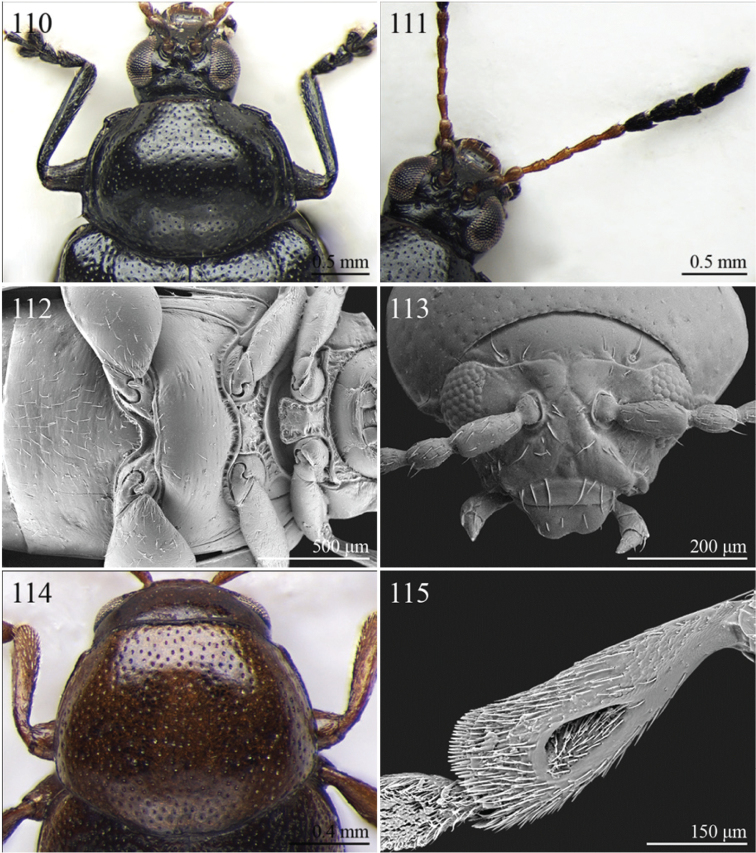
Morphological characters. 110
Abrarius aethiops (Weise), head and pronotum in dorsal view 111 Ditto, head and right antenna in dorsal view 112
Abrarius cribrosus Fairmaire, ventral parts 113
Afroaltica parvula D’Alessandro & Biondi, head in frontal view 114
Afroaltica subaptera Biondi & D’Alessandro, head and pronotum in dorsal view 115 Ditto, triangular hollow on ventral side of middle tibiae in male.